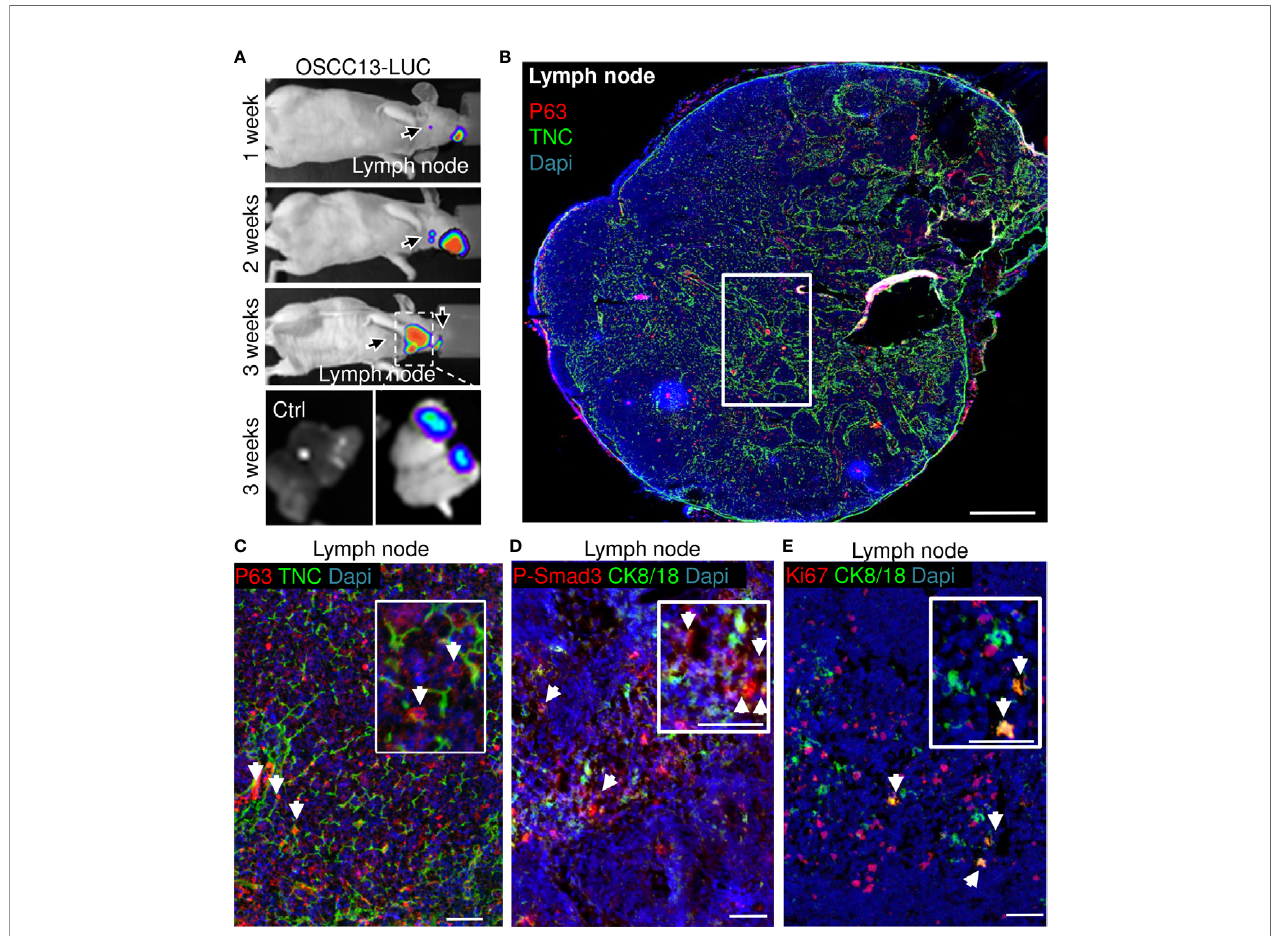
FIGURE 4 | OSCC13 tumor cells home to the local lymph nodes and expand. (A) Detection of luciferase expressing OSCC13 cells in the lymph node by a Nightowl imaging machine in a nude mouse and in the dissected lymph nodes. Luciferin signal in the tumor and, expanding in the lymph node from 1 – 3 weeks. N = 3 mice. (B – D) , OSCC13 cells were engrafted in a C57Bl/6J mouse. (B) Representative result (N = 3) of disseminated OSCC13 cells in the lymph node by p63 (C) and P- Smad3 (D) staining and proliferating CK8/18+ tumor cells by Ki67 staining (E). Note tumor cells (p63+) to be placed in TNC+ matrix (inlet of C ) and proliferation of tumor cells (CK8/18+) (E) , con fi rming tumor cell expansion in the lymph nodes presumably forming metastasis in the immune competent context like in nude mice (A) . N = 3 mice. Scale bar, 500 µm (B) and 50 µm (C – E) . Arrows point at tumor